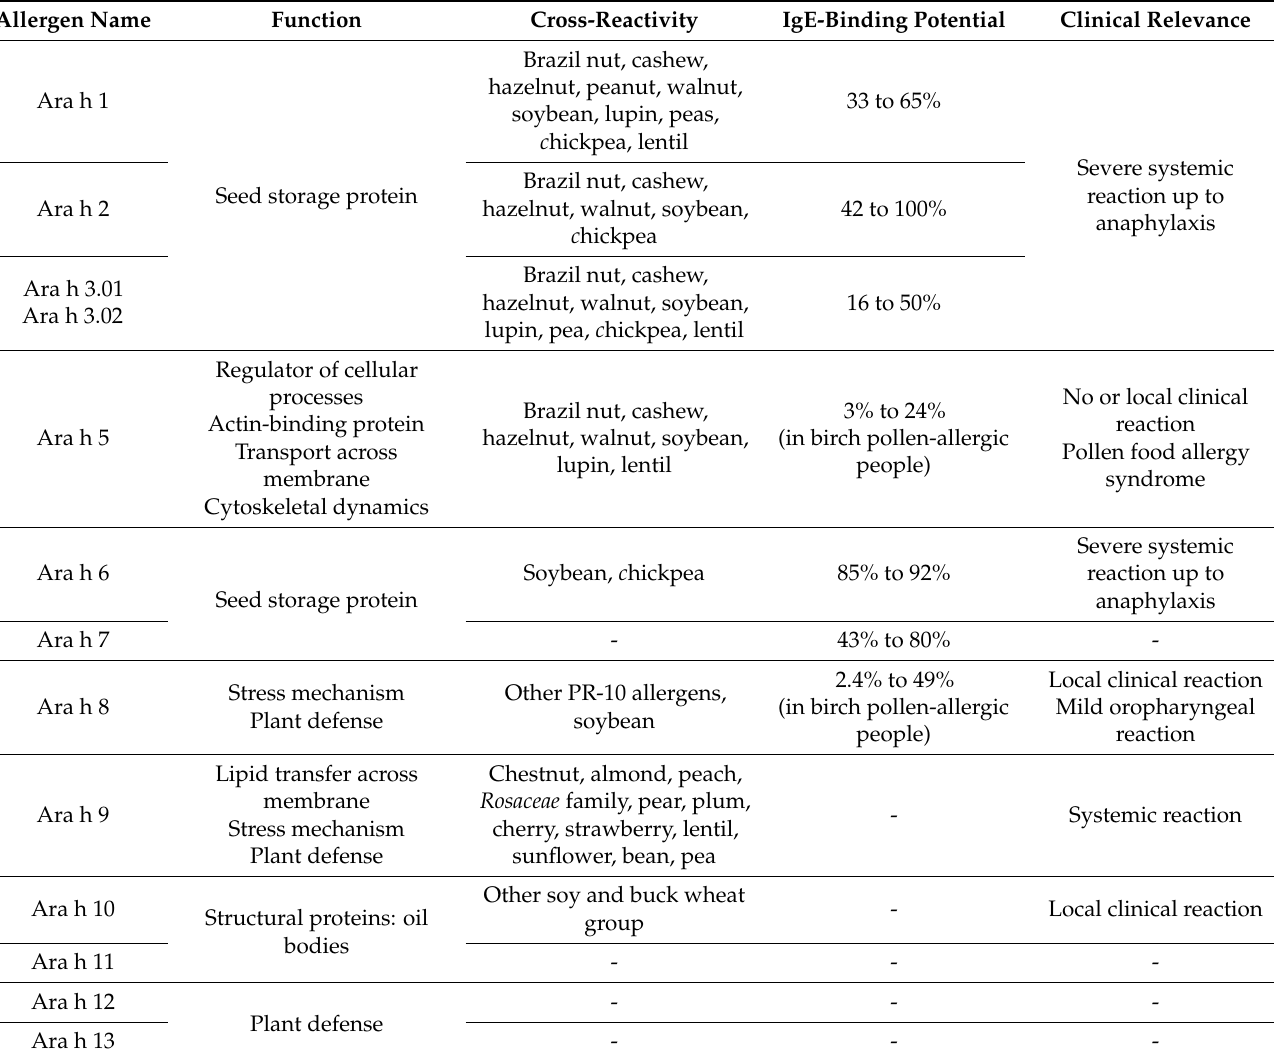
Table 2. Functions of peanut allergens, cross-reactivity, and clinical